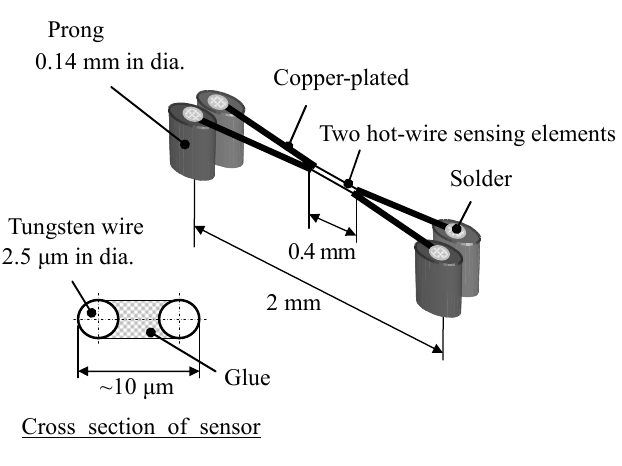
Fig. 1 Schematic diagram of the new hot-wire